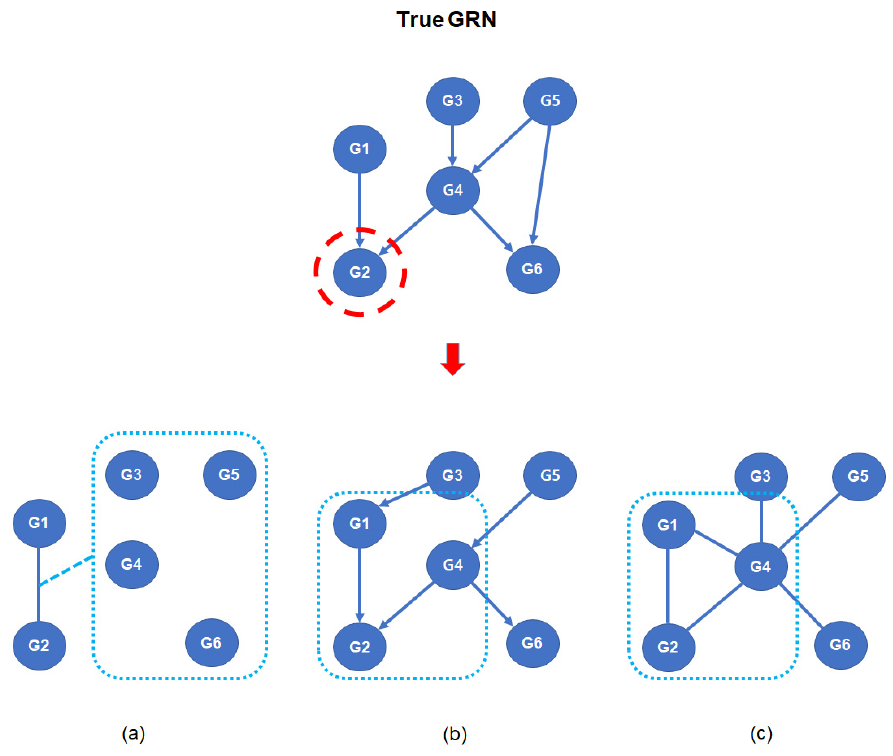
Figure 2. GRN inference with GGM, BN, and MRF. When G2 is a target gene (red dot circle), ( a ) GGM estimates the regulatory relationship with G2 using conditioning of other genes, ( b ) BN infers a directed parent–child structure by assigning conditional probability, and ( c ) MRF decomposes a multivariate distribution using identification of a dependency structure with potential function. The rounded rectangles of ( a – c ) indicate the remaining genes, the parent–child relationship, and the dependency structure, respectively. GRN: Genetic Regulatory Network, G: gene, GGM: Gaussian Graphical Model, BN: Bayesian Network, MRF: Markov Random Field.